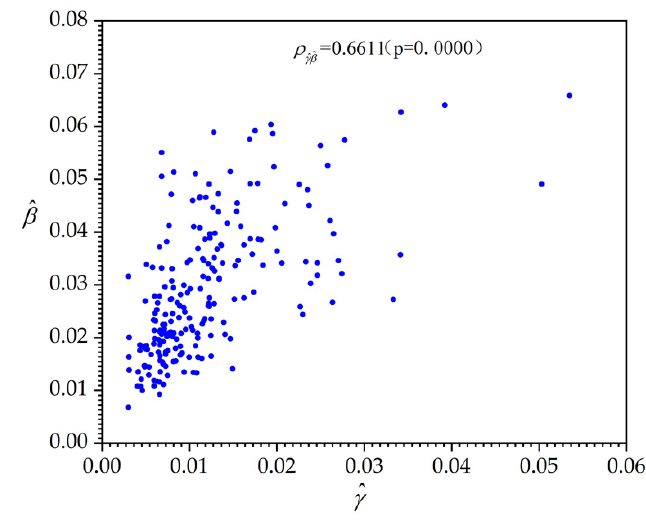
Figure 5. Correlation between ˆ γ and ˆ β .